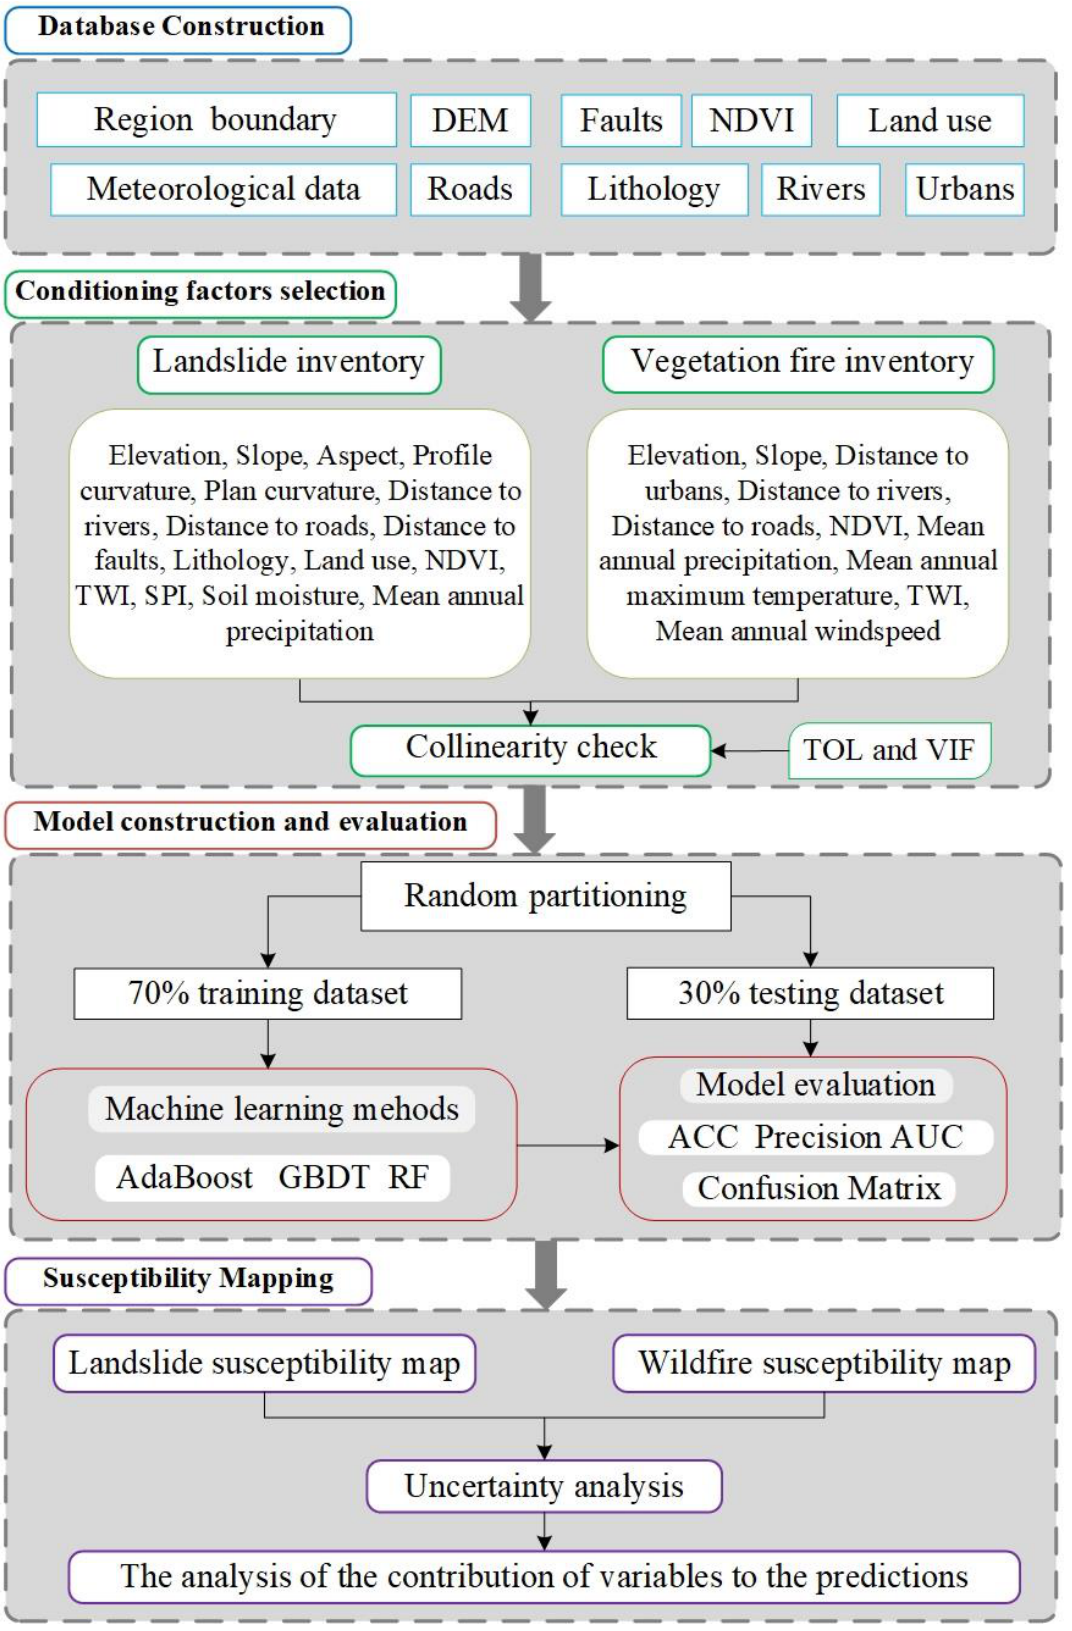
Figure 3. Flow chart of the landslide and wildfire susceptibility modeling and mapping in this paper.